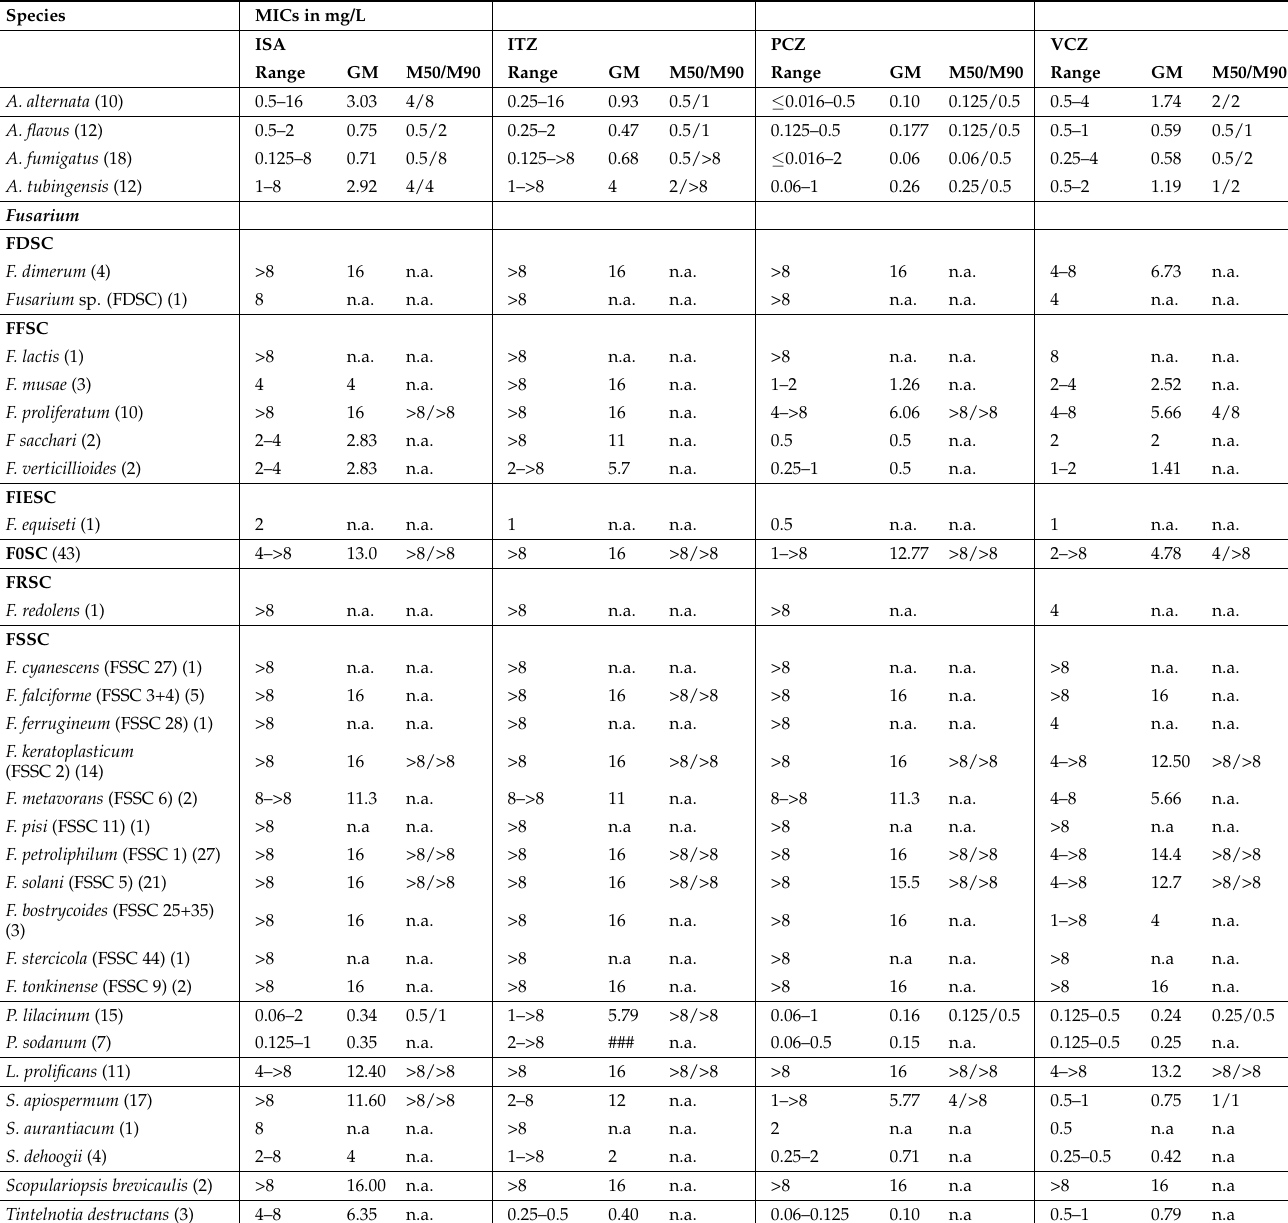
Table 3. Antifungal susceptibility of species isolated from infected eyes against isavuconazole (ISA), itraconazole (ITZ), posaconazole (PCZ), and voriconazole (VCZ). For the FSSC, the numbering of the phylogenetic species is given in the first